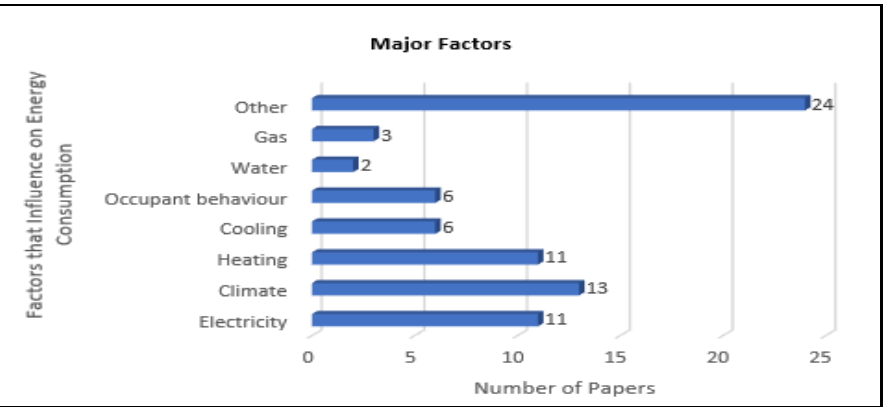
Figure 13. The most relevant factors that influence the energy consumption of buildings, from our survey.